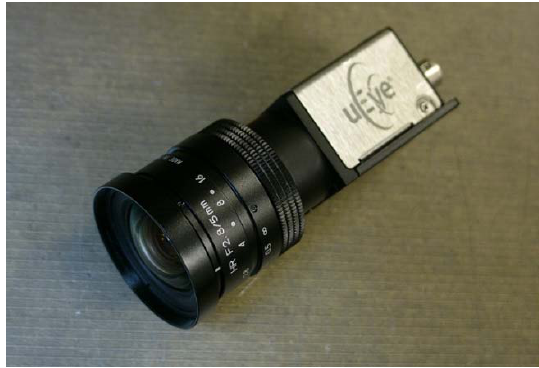
Figure 4. uEye camera fitted with the ‘nobrand’ 5mm lens. The filters were mounted at the narrow end of a customised snoot, an opaque aluminium enclosure into which the flash lamp fitted snugly. Taping around the join prevented white flash light from escaping into the room. The only light emitted was through the filter at front, with a beam angle of ~20°. Two datasets were acquired at different times with the same lens but with two different camera bodies, to test for repeatability: (1) 12 images for each of the 21 filters; (2) 16 images for each of a subset of 12 filters, consisting of seven at 60nm intervals from 400 to 700nm, and five at 50nm intervals from 750 to 950nm. Although the flash light source was the same in each case, the light was diffused by different means: (1) a sheet of opal perspex was placed in front of the filter; (2) the light assembly was fitted inside a photographic ‘softbox’ (Fig. 5).